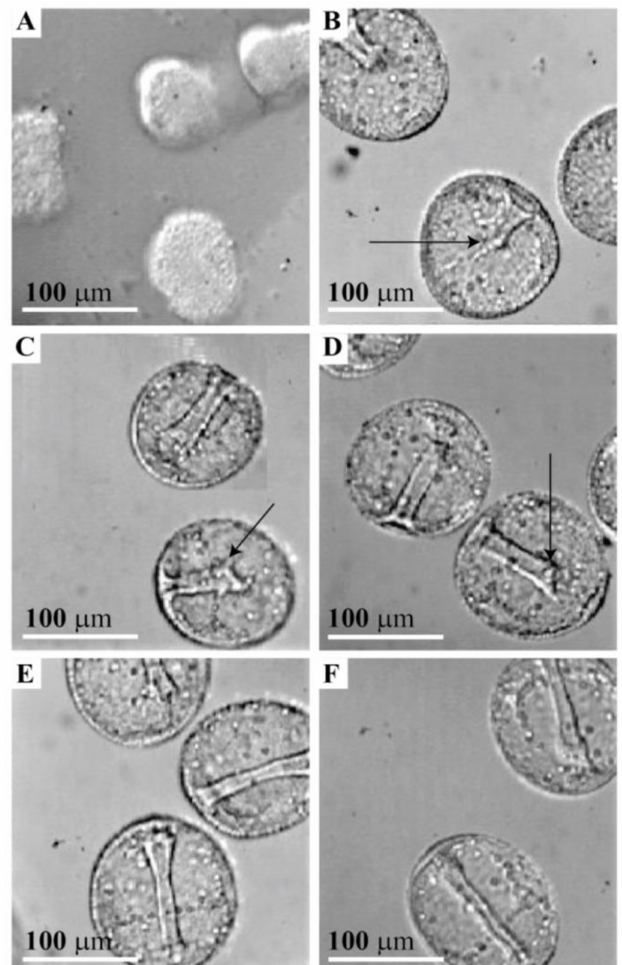
Figure 7. Alterations of embryo integrity and inhibition of gastrulation by the anti GN1 Block 2 monoclonal antibody. Hatched blastula embryos were grown in 100 µ L FSW to which different concentrations of purified monoclonal antibodies were added. Inhibition of gastrulation and shape changes were scored during 24 h incubation at 16 ◦ C with the ( A ) 10 µ g Block 2, ( B ) 5 µ g Block 2, ( C ) 2.5 µ g Block 2, ( D ) 1.25 µ g Block 2, ( E ) 10 µ g control mouse C-16 monoclonal antibody, and ( F ) control untreated embryos. Arrows mark